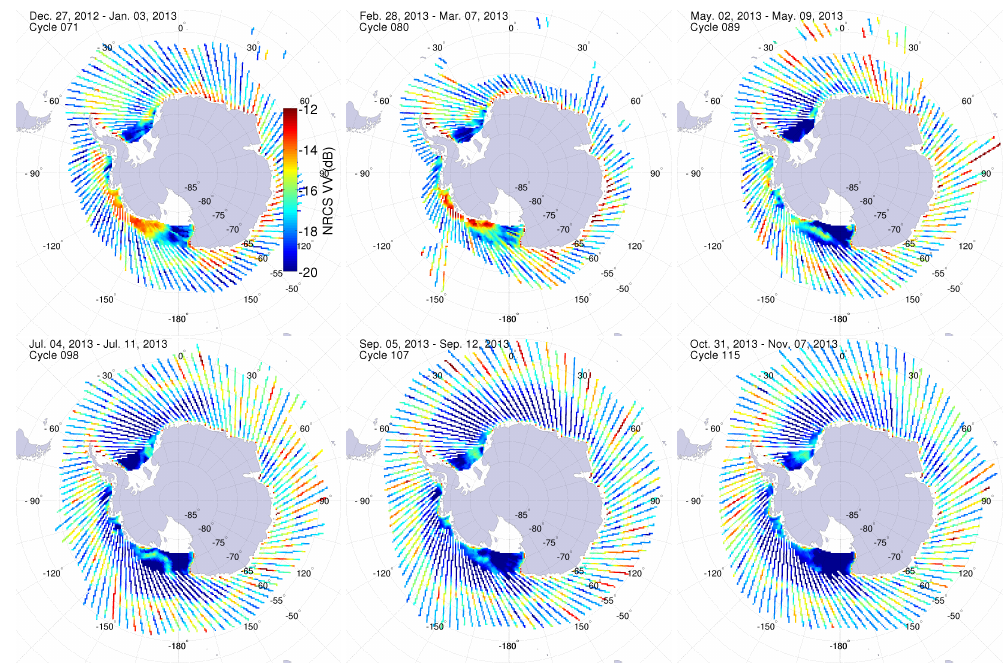
Fig. 15. Maps of beam 3 NRCS VV over the SH sea ice every two months in 2013. Grid cells where the land fraction was more than 0.25 were masked.